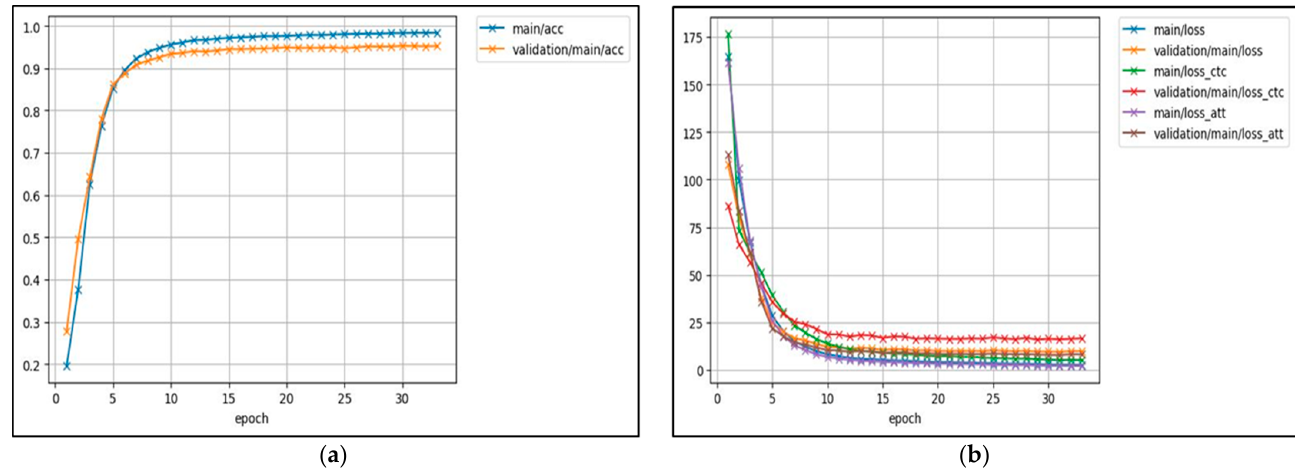
Figure 6. The training processes of the proposed method: ( a ) accuracy vs. epoch and ( b ) validation loss vs. epoch during network training.